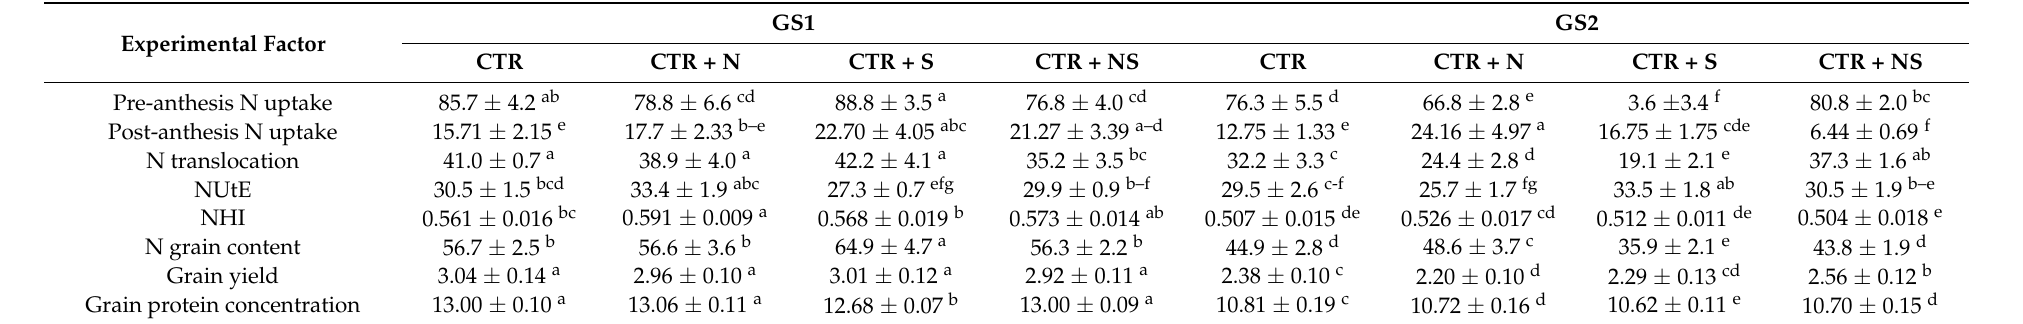
Table 2. Effect of interaction growing season × fertilization strategies on pre-anthesis N uptake (kg ha − 1 ), post-anthesis N uptake (kg ha − 1 ), N translocation (kg ha − 1 ), nitrogen utilization